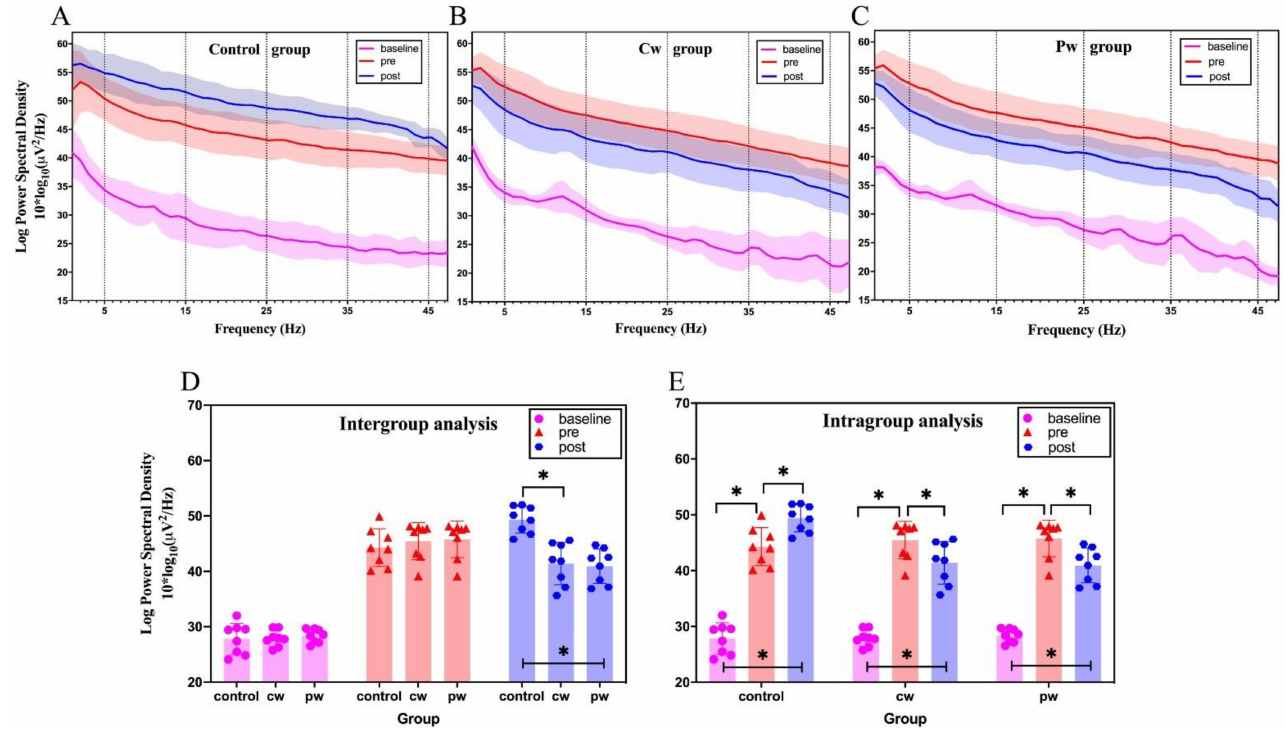
Figure 6. The raw EEG power spectral density (PSD). ( A ) Distribution of PSD in each frequency band in the control group. ( B ) Distribution of PSD in each frequency band in the cw group. ( C ) Distribution of PSD in each frequency band in the pw group. ( D ) The intergroup analysis of PSD in different stages. ( E ) The intragroup analysis of the three groups. * indicates significance ( p <